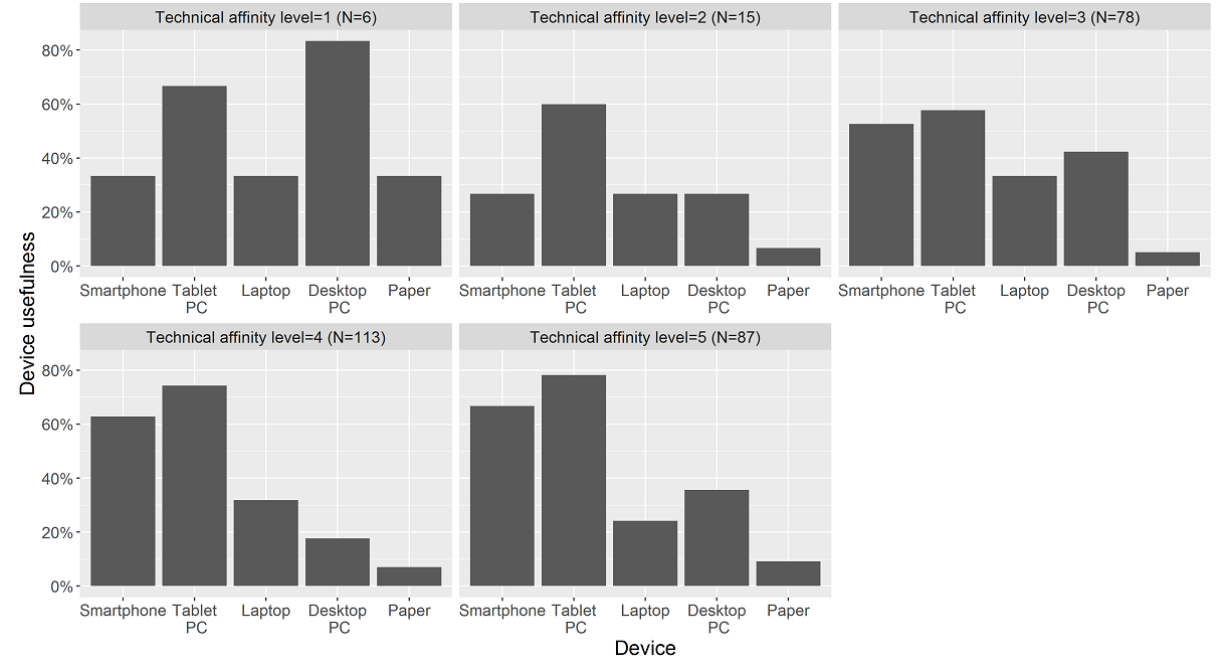
Figure 4. Device preference stratified by (self-reported) technical affinity level.